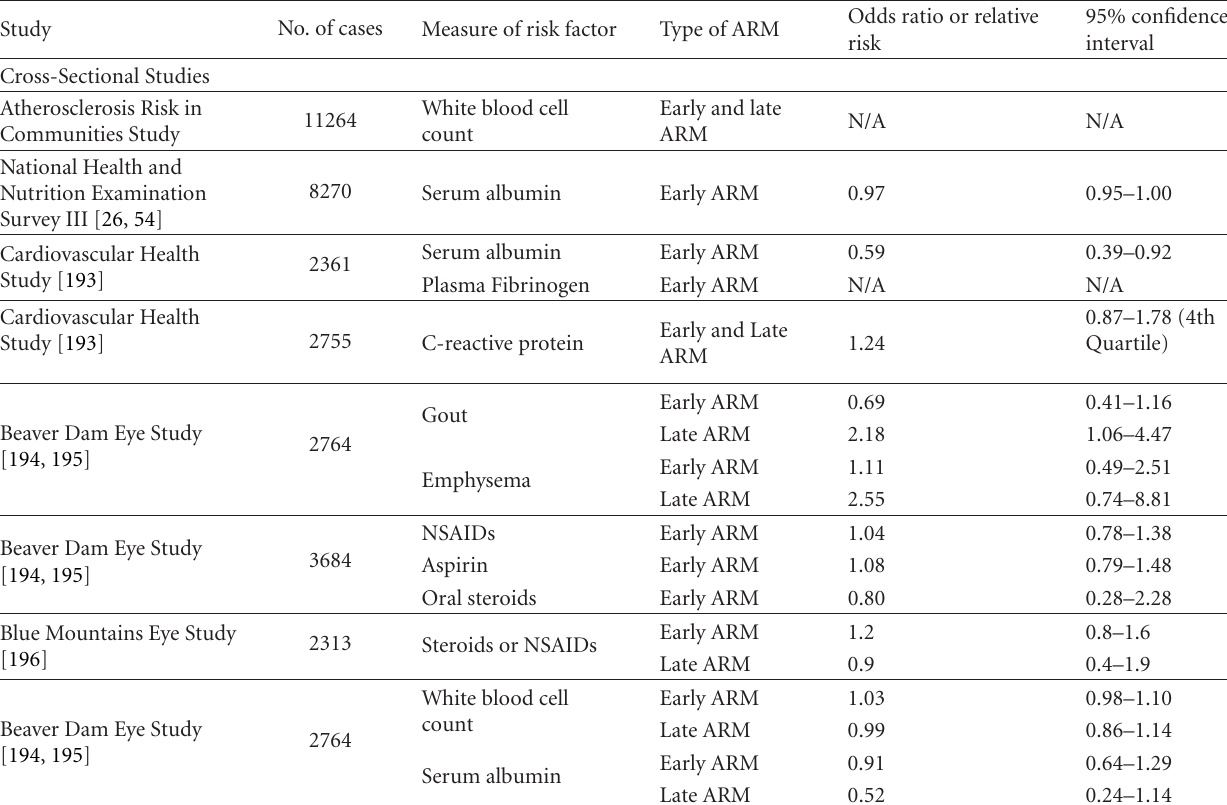
Table 8: Studies investigating the relationship between indicators of inflammation and risk for